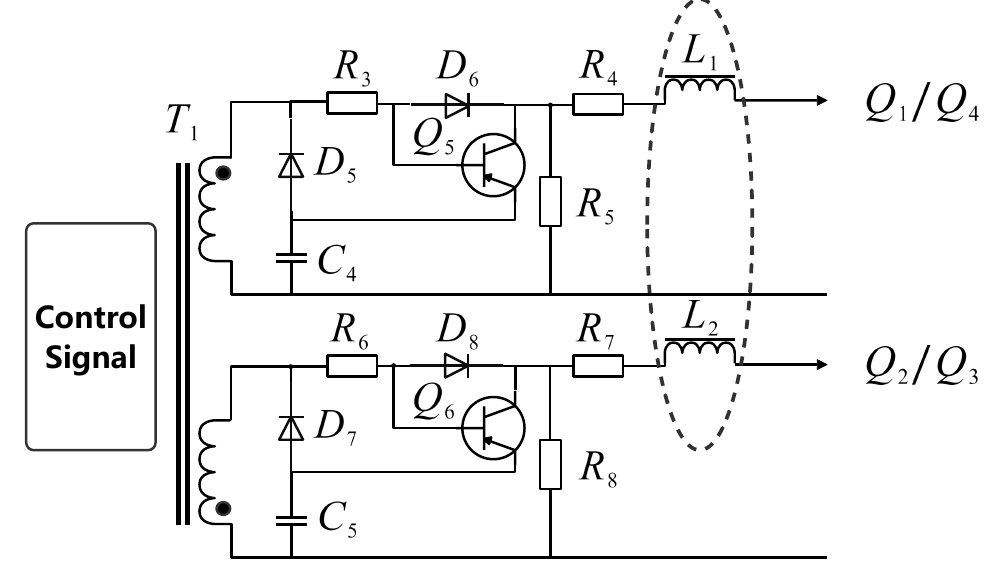
Figure 7. Structure of the drive